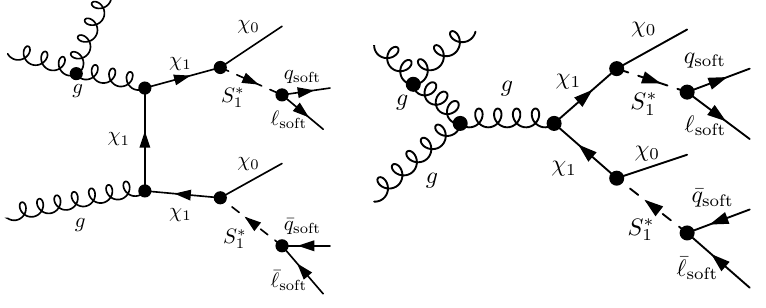
Figure 5 . Feynman diagram representing mono-jet production (plus soft leptons and quarks) in the model